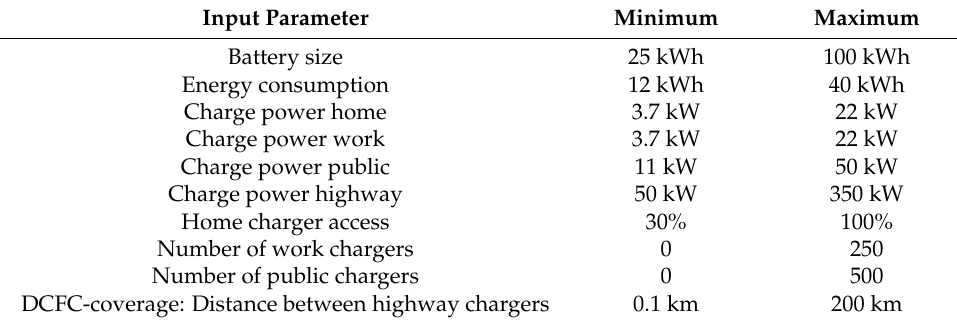
Table 3. Parameter variations used for the global sensitivity